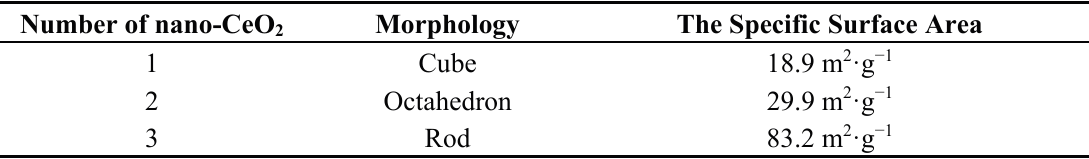
Table 2. Surface area of synthesized nano-CeO 2